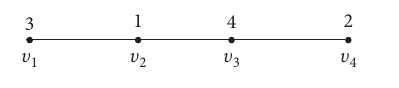
Figure 5: A path P 4 labelled by SL21-labelling.